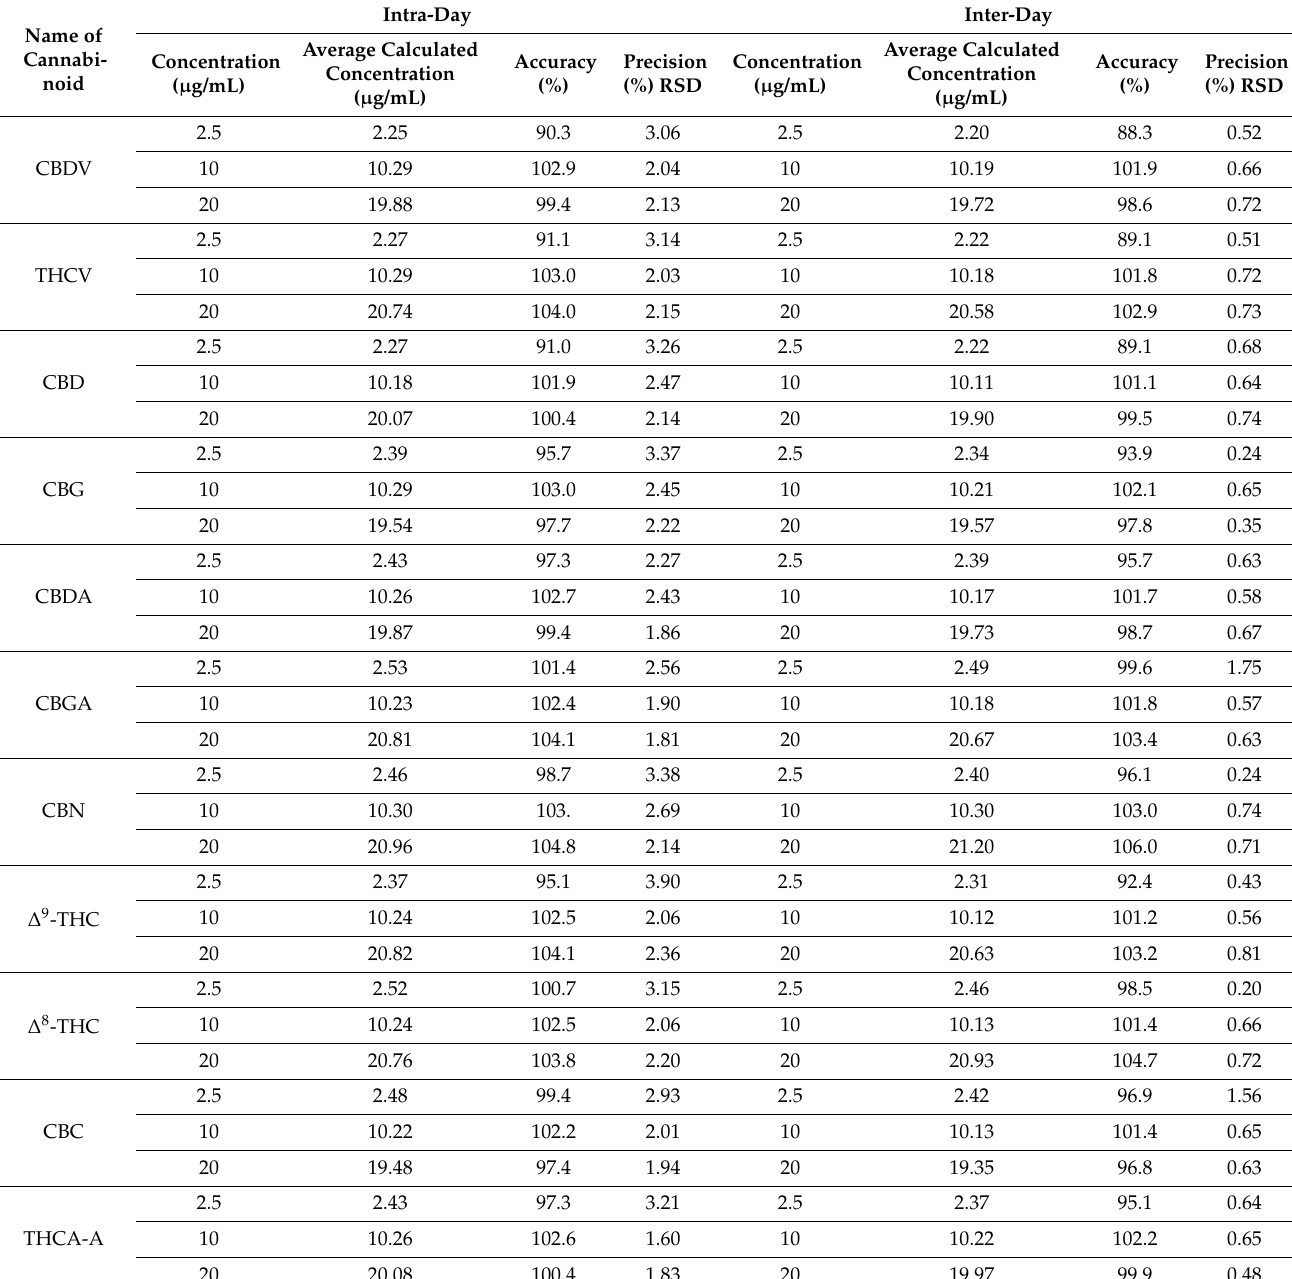
Table 3. Precision and accuracy of 11 cannabinoids on intra-day and